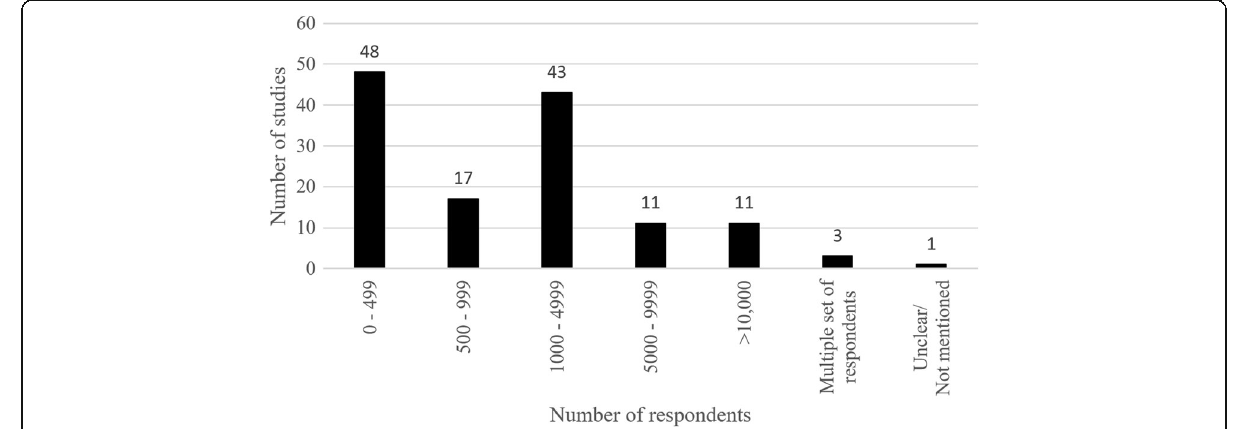
Fig. 6 Sample sizes of the reviewed